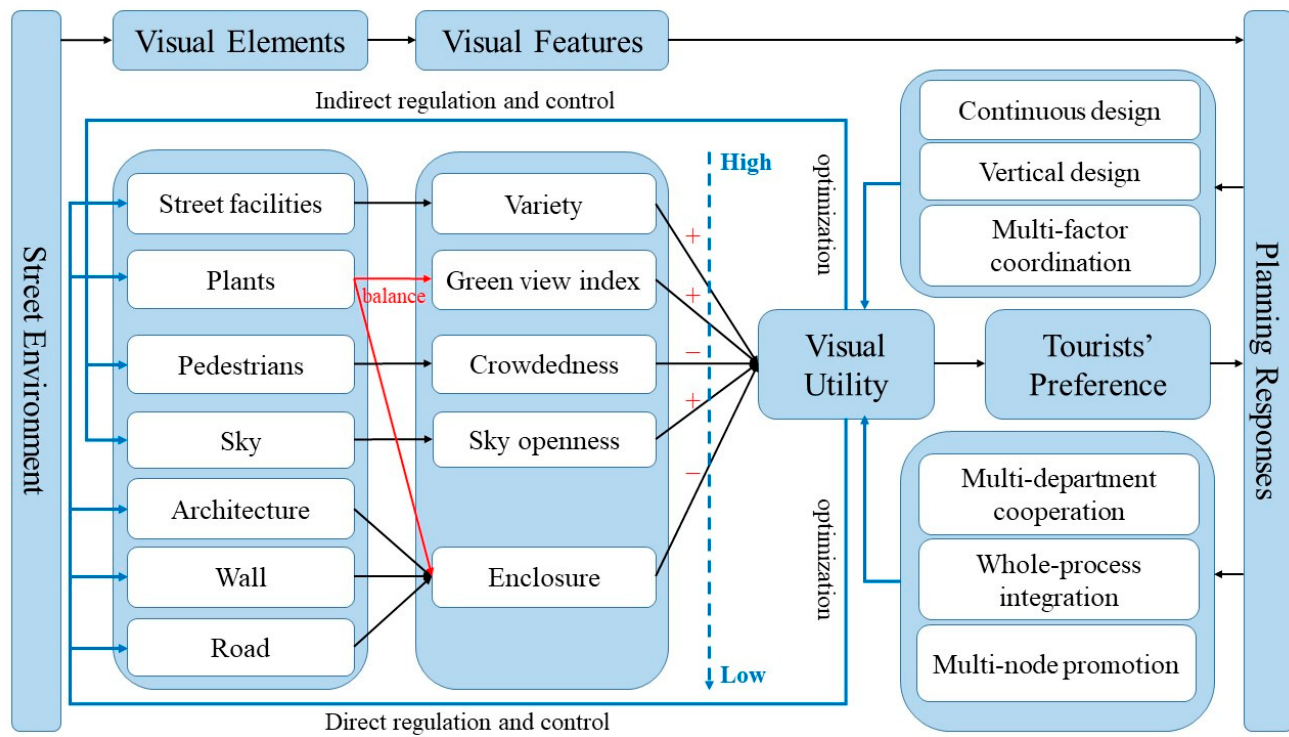
Figure 6. Optimization paths of street environments based on visual preference.